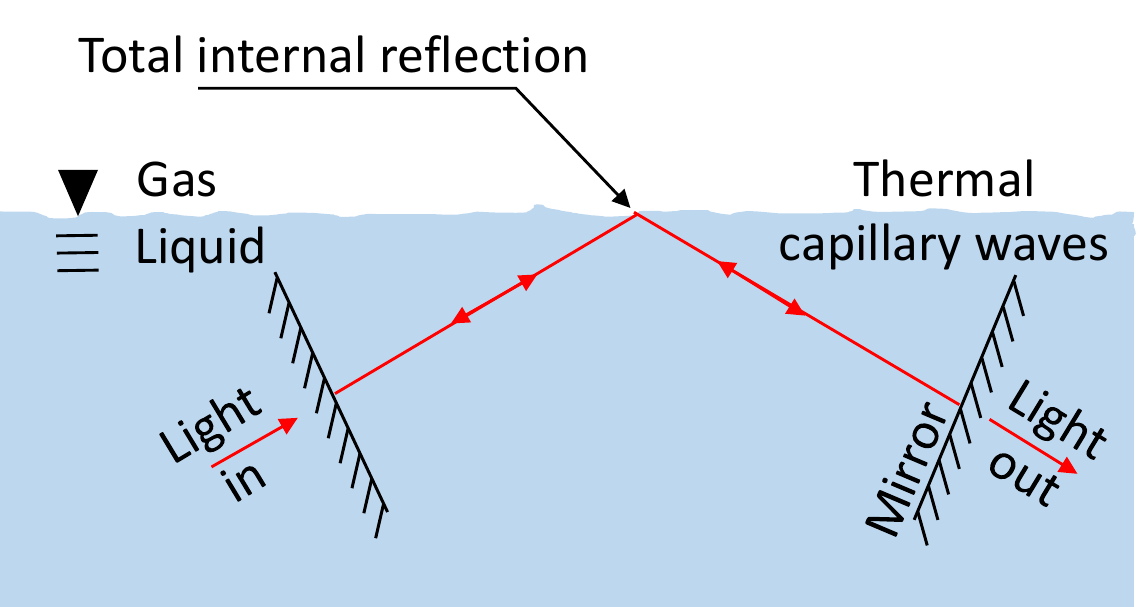
Figure 1. Schematic description of our resonator, where we use total internal reflection from a gas-liquid interface as one of the reflectors. As such, the cavity roundtrip length is affected by thermal capillary waves at the liquid-phase boundary.